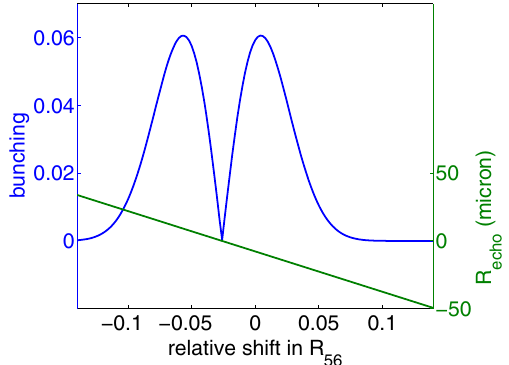
FIG. 2. Dependence of the magnitude of the bunching param- eter as the value of R 1 is varied. All other parameters are kept fixed. Incoherent radiation and scattering have been